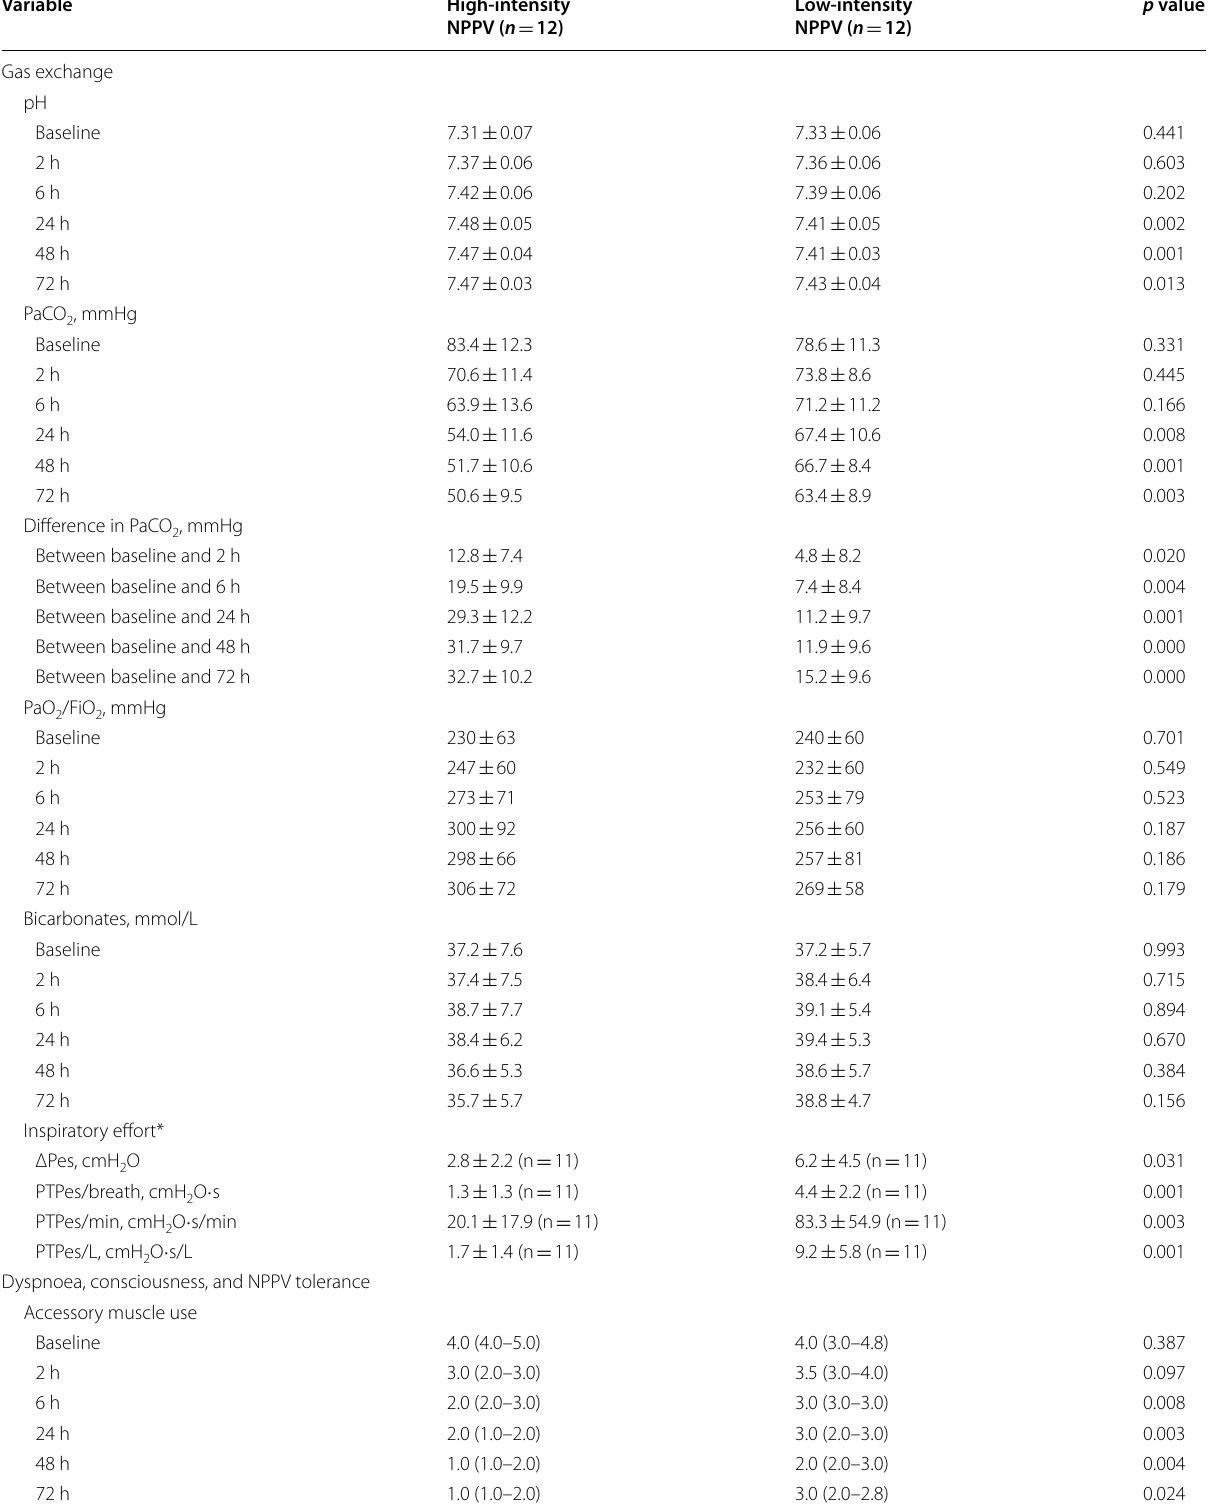
Table 2 Gas exchange, inspiratory effort, dyspnoea, consciousness, and NPPV tolerance